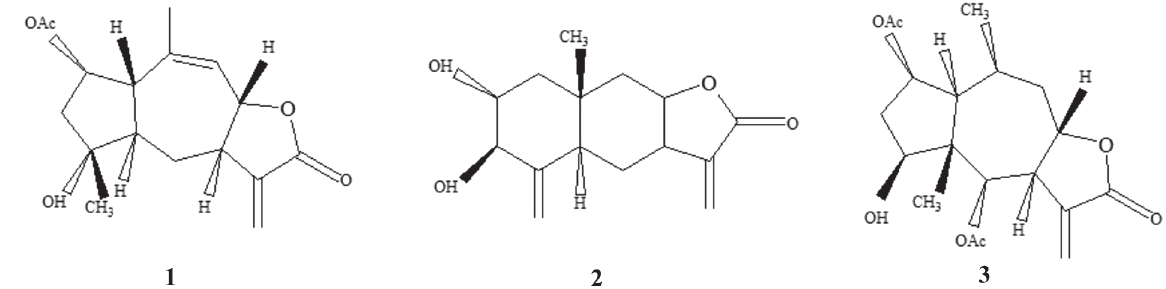
Figure 1 - Chemical structures of gaillardin ( 1 ), pulchellin C ( 2 ) and britannin ( 3